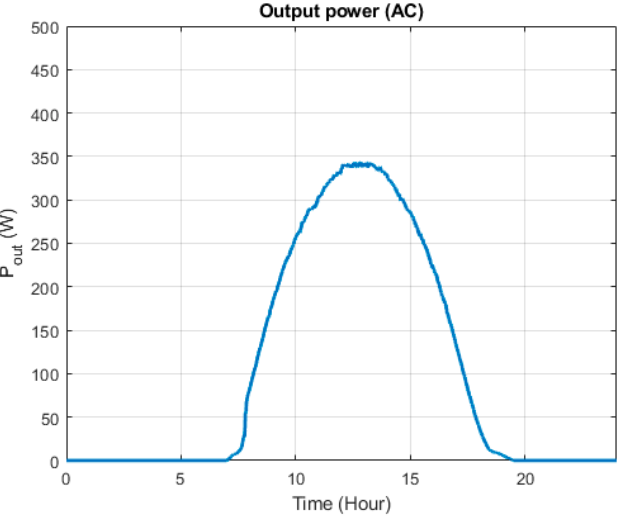
Figure 10. Output power, P OUT on a September day.